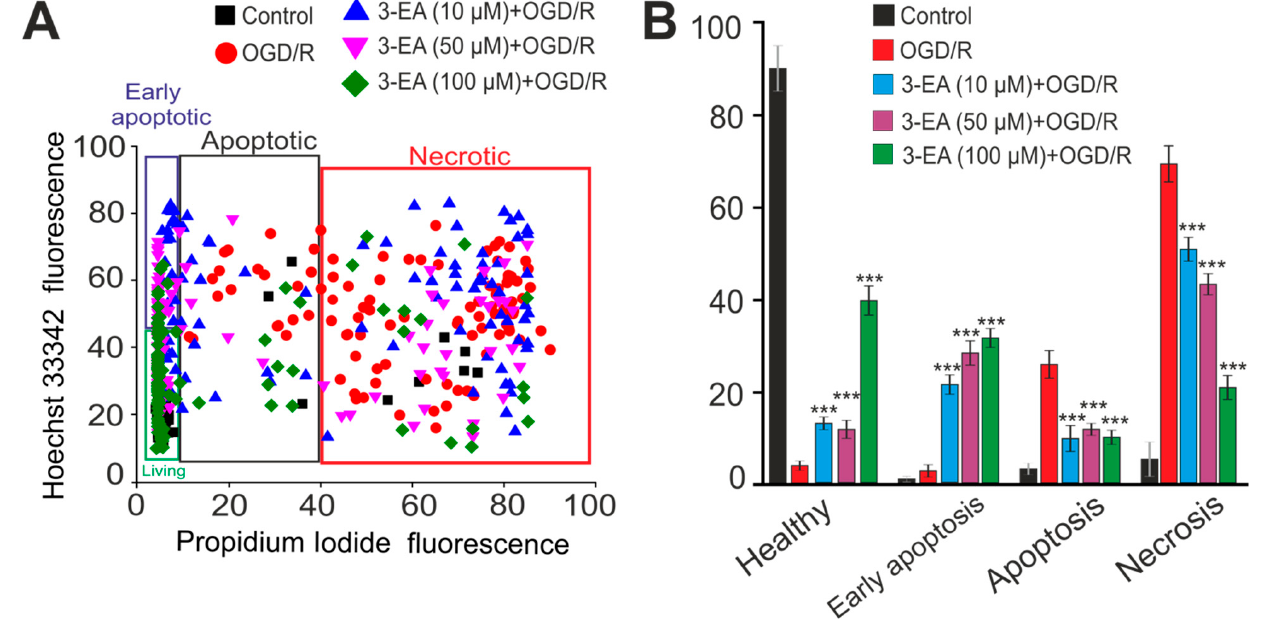
Figure 5. An effect of 24 h preincubation of the cortex cells with various concentrations of 3-EA on the viability of the cells during 2 h oxygen-glucose deprivation with subsequent reoxygenation during 24 h (OGD/R): ( A ) Cytogram showing the viability of cerebral cortex cells (horizontal axis–propidium iodide fluorescence intensity; vertical axis–Hoechst 33342 fluorescence intensity). Cells were stained with probes after 24 h of reoxygenation. ( B ) An effect of 24-h preincubation of the cortex cells with various concentrations of 3-EA on the induction of necrosis and apoptosis with OGD/R: The results are presented as mean ± SD, number of cell cultures = 3; number of coverslips with cells for each sample = 5; n/s-data are unreliable ( p > 0.05), *** p < 0.001 when comparing experimental groups with GluTox (ANOVA and Tukey’s post-hoc